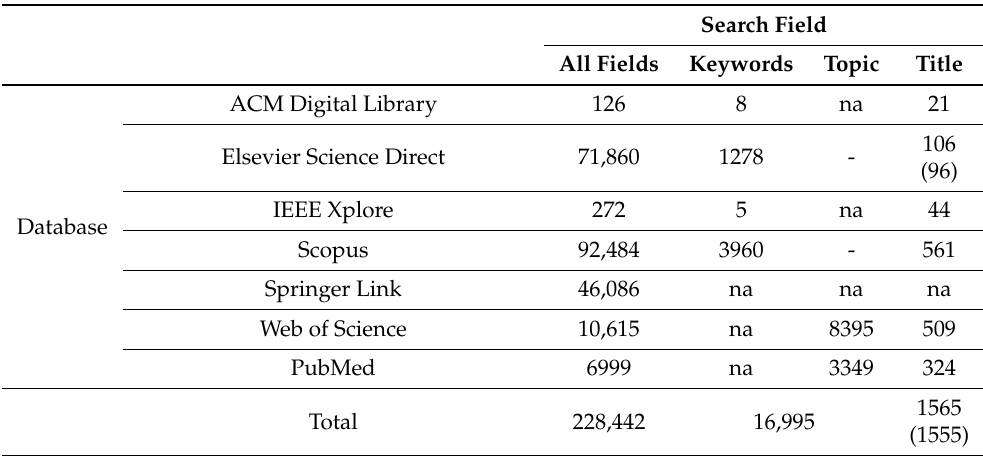
Table 1. Number of results obtained for each database and search field.